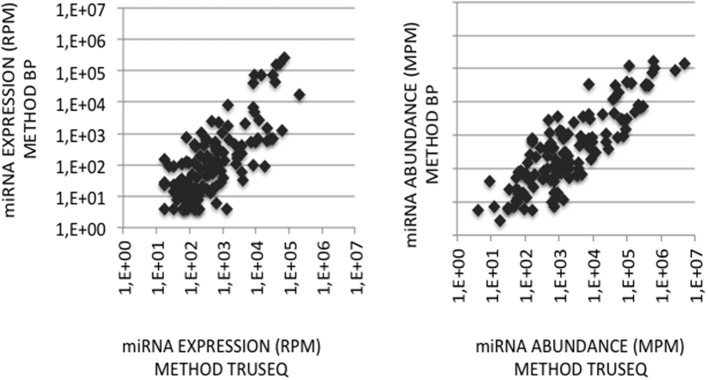
miRNA quantification in cerebellum. (Left Graph) miRNA expression profiles were established following the sequencing of two cDNA libraries constructed from the same cerebellum RNA sample and Illumina-based protocol but with 3′-adaptors RA3 (current TruSeq protocol) or BC8 (previous protocol). miRNA expressions in the BC8 profile were plotted against miRNA expressions in the RA3 profile. Data are expressed in Reads per Million (RPM). Both variables display a Pearson coefficient of correlation R2 of 0.54. (Right Graph) miRNA abundances in the cerebellum sample were calculated from each miRNA expression profile corrected with its corresponding ECs/correcting factors. miRNA abundances in the sample obtained using ECs/correcting factors BC8 were plotted against miRNA abundances calculated using ECs/correcting factors TruSeq. Data are expressed in Molecules per Million (MPM). Both variables display a Pearson coefficient of correlation R2 of 0.71. X- and Y-axes are drawn using a log10 scale.